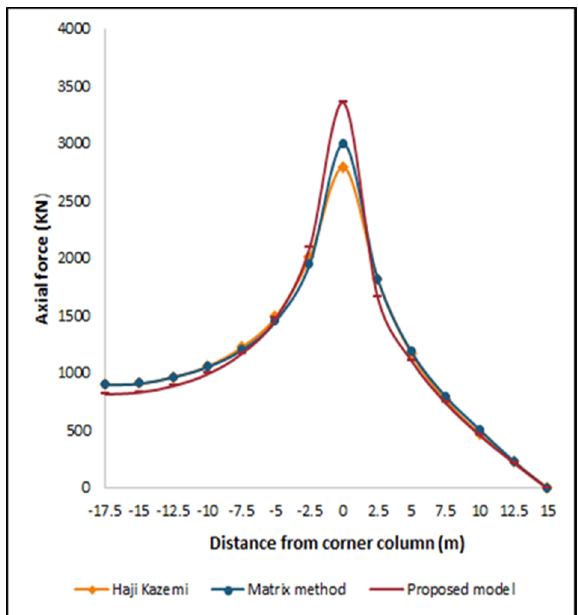
Figure 10. Axial force distribution in the flange and web columns at the base of the building.